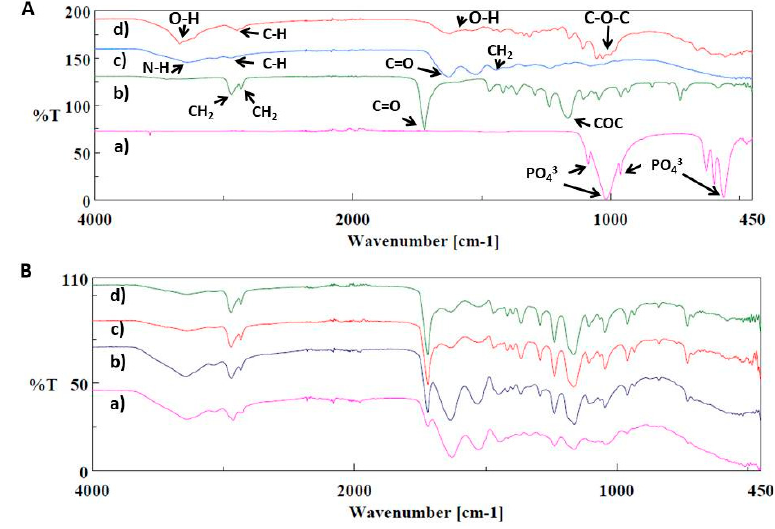
FTIR spectrums of ( A , a ) pure hydroxyapatite, ( A , b ) pure PCL, ( A , c ) pure gelatin, ( A , d ) pure bacterial cellulose, ( B , a ) PCL / GEL, ( B , b ) PCL / GEL / BC, ( B , c ) PCL / GEL / BC / 0.25%HA, ( B , d ) PCL / GEL / BC / 0.50%HA.